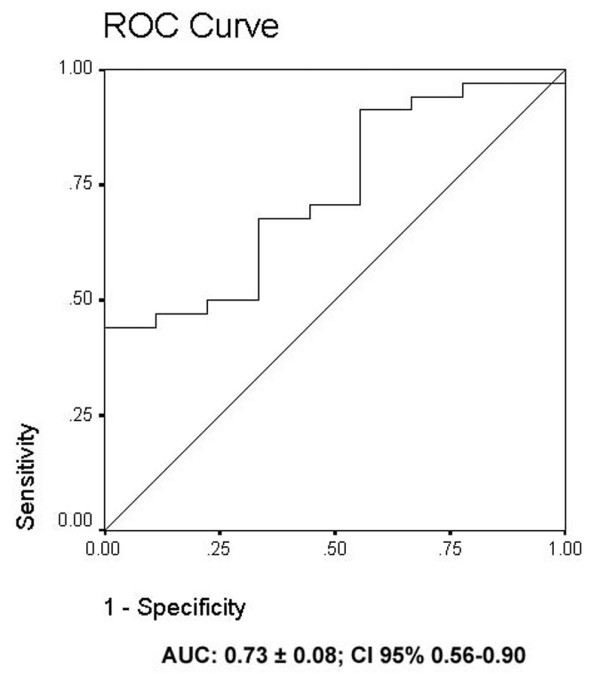
Receiver operating characteristics curve for neuron-specific enolase levels after in-hospital cardiac arrest. AUC, area under curve; CI, confidence interval.